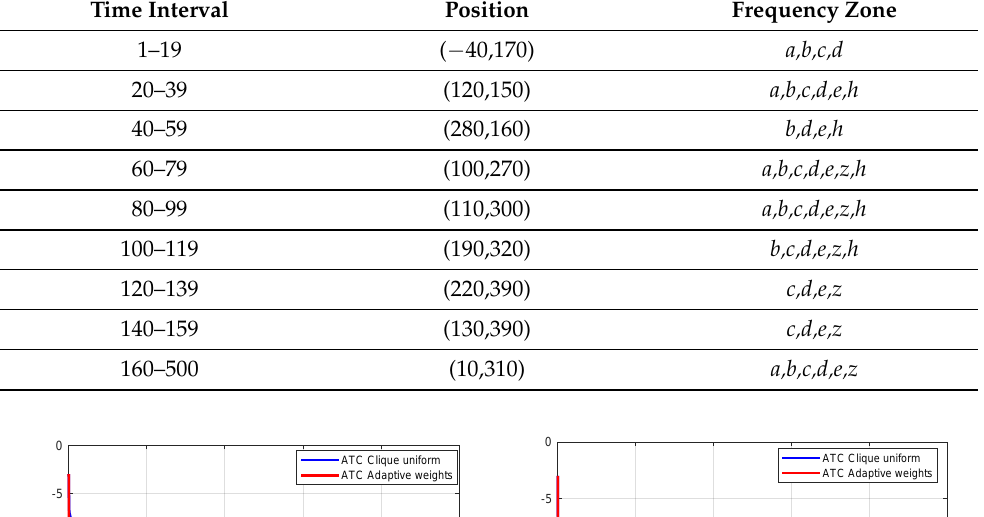
Table 3. Mobile CR node positions and frequency zones.